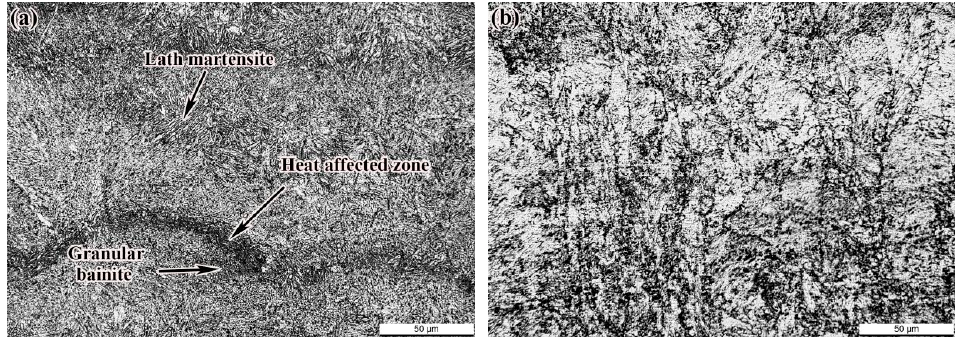
Figure 10. Micro-morphology of the sample: ( a ) as-deposited; ( b ) SR.